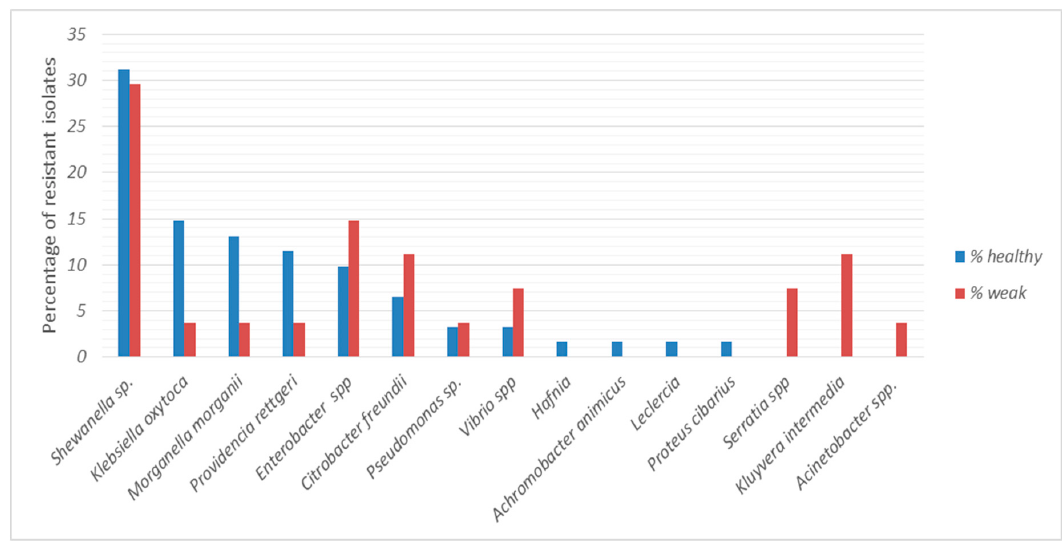
Figure 4. The relative percentage of bacteria identified in cloacal swabs from healthy ( n = 23) and weak ( n = 10) turtle cloacal samples is reported.